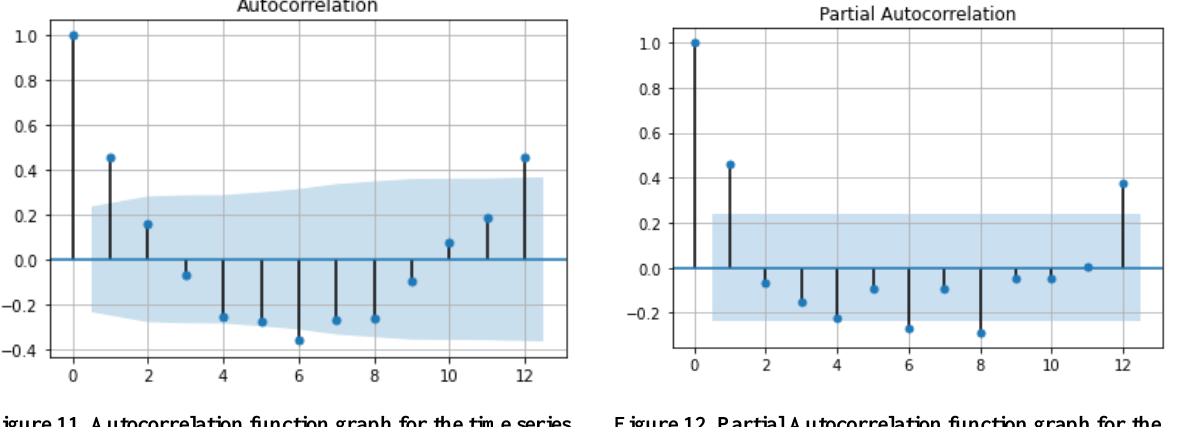
Figure 12. Partial Autocorrelation function graph for the time series of total Italian’s deaths